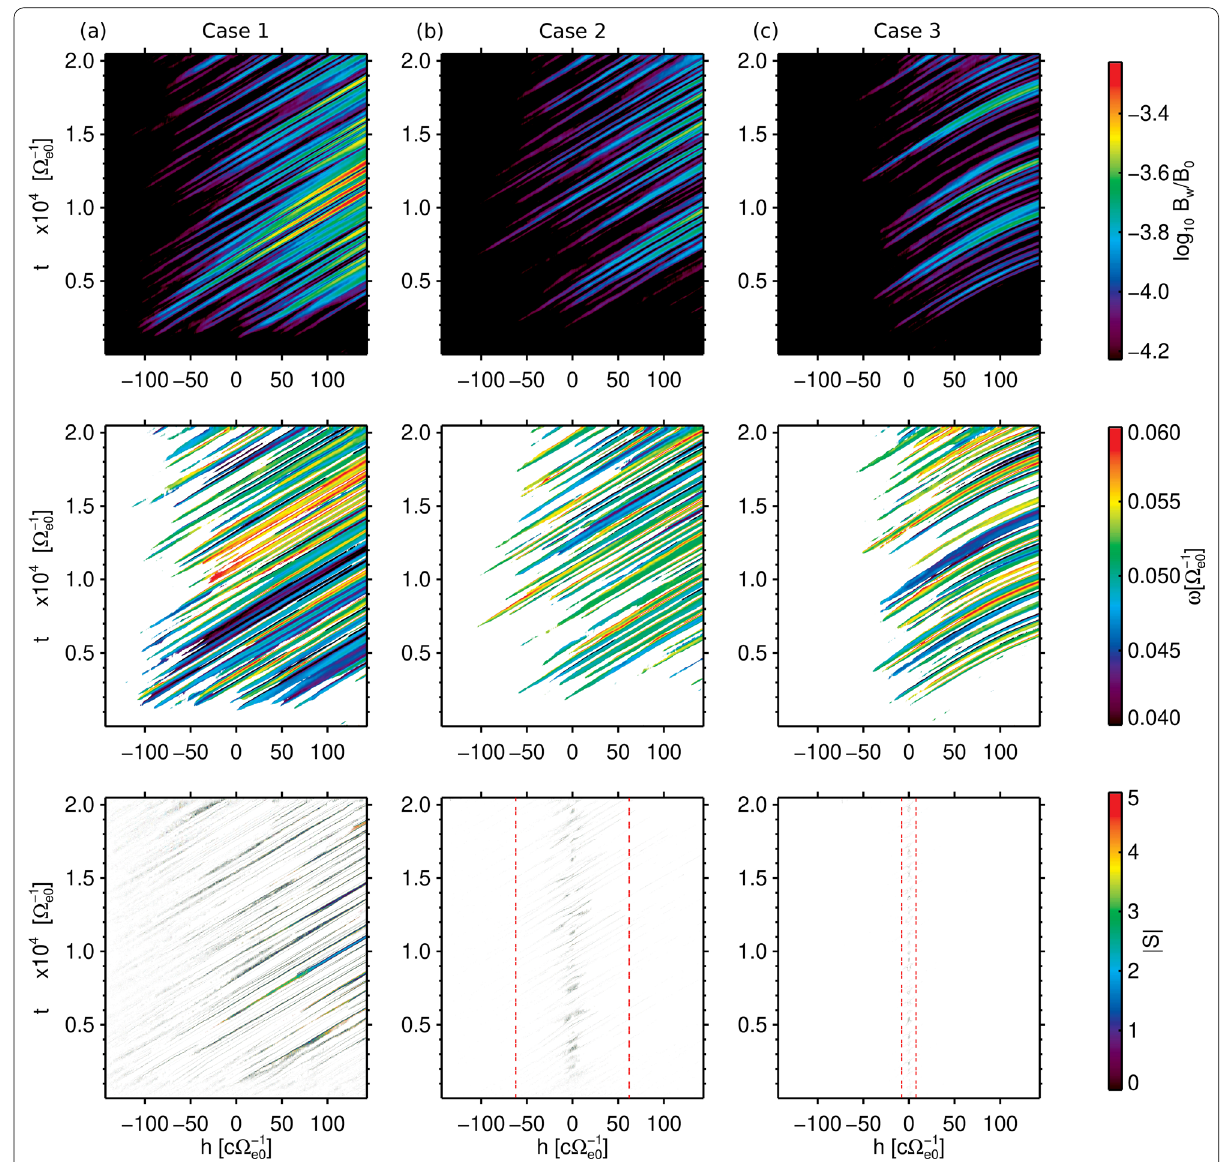
Fig. 7 Spatial and temporal evolution of wave amplitude (top panels), wave frequency (middle panels) and inhomogeneity factor S (bottom panels) of forward-propagating waves ( t = 0 ∼ 2.04 × 10 4 [ (cid:31) − 1 e 0 ] ), after implementing a band-pass filter of 0.04 ∼ 0.06 (cid:31) e 0 . Here, column a corresponds to Case 1 ( a = 1.87 × 10 − 7 (� e 0 / c ) 2 ), column b corresponds to Case 2 ( a = 3.74 × 10 − 6 (� e 0 / c ) 2 ), column c corresponds to Case 3 ( a = 3.74 × 10 − 5 (� e 0 / c ) 2 ). The red dashed lines represent critical distances in Case 2 and Case